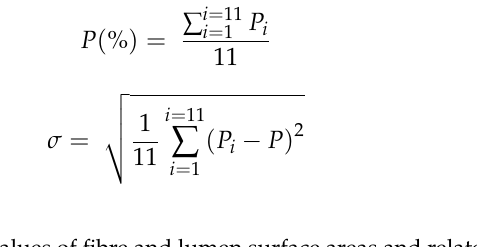
Table 1. Mean and extremum values of fibre and lumen surface areas and related porosity content measured from 11 complete fibres on the topological mappings (Figure